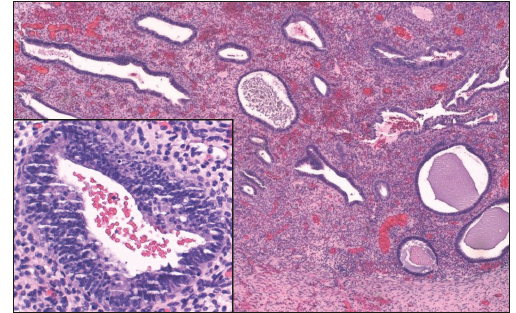
Figure 2: Multiple cysts lined by ciliated tubal-like cuboidal epithelial cells without atypia (Hematoxylin and Eosin × 4. Inset: Hematoxylin and Eosin × 20).